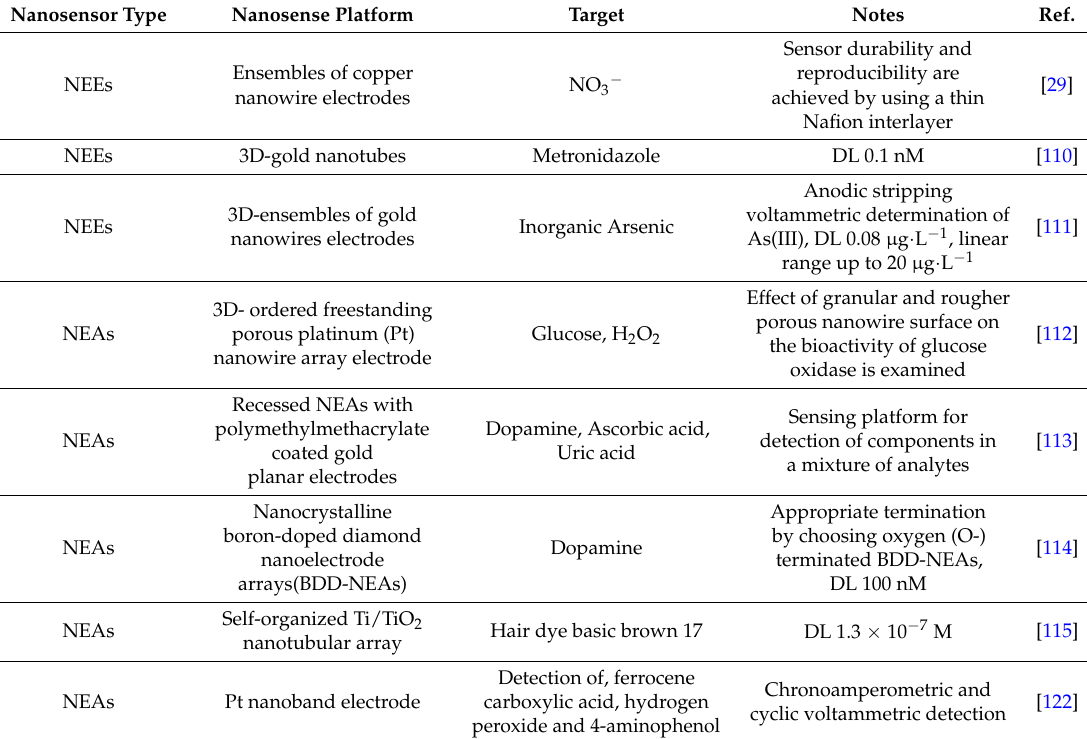
Table 1. Articles published in the years 2012–2016, dealing with the application of NEEs/NEAs for the direct detection of small molecules of biological